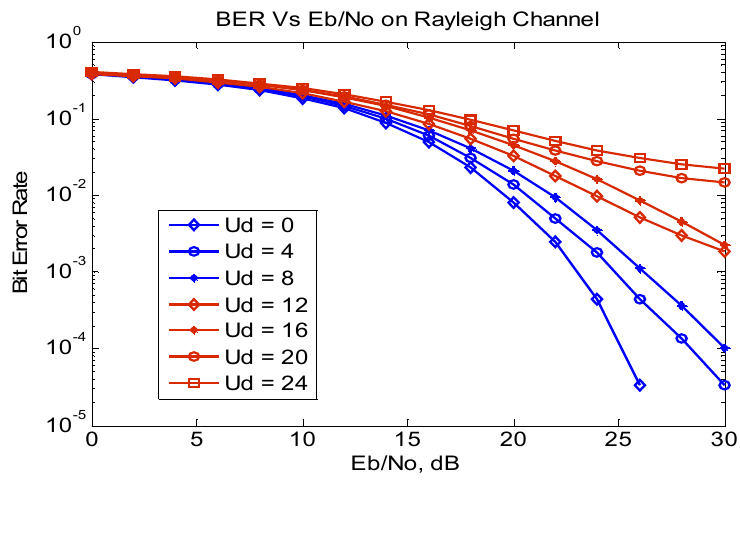
Figure 6. The BER performance of MC-CDMA system for varying number of deactivated subcarriers